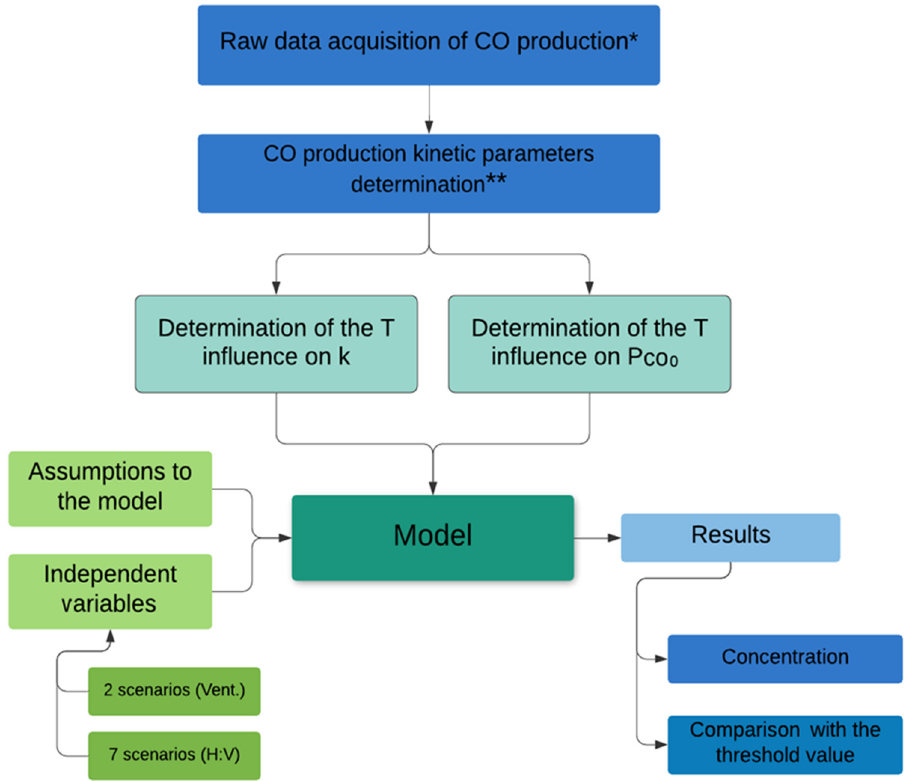
Figure 1. Model outline for prediction of CO accumulation during composting of biowaste under different scenarios of compost headspace ventilation and temperature; * data published in [27], ** estimated using raw data in [29].